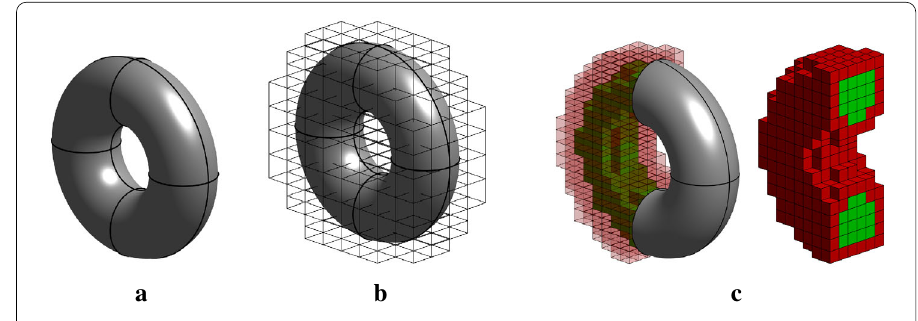
Fig. 2 Disctretization mesh of a torus in cgFEM. In green, elements internal to the domain. In red, elements cut by the boundary ( boundaryelements ). Elements completely outside the domain are not considered during the analysis. a Phys. domain (cid:2) . b Discretization (cid:2) h . c Internal and boundary elements